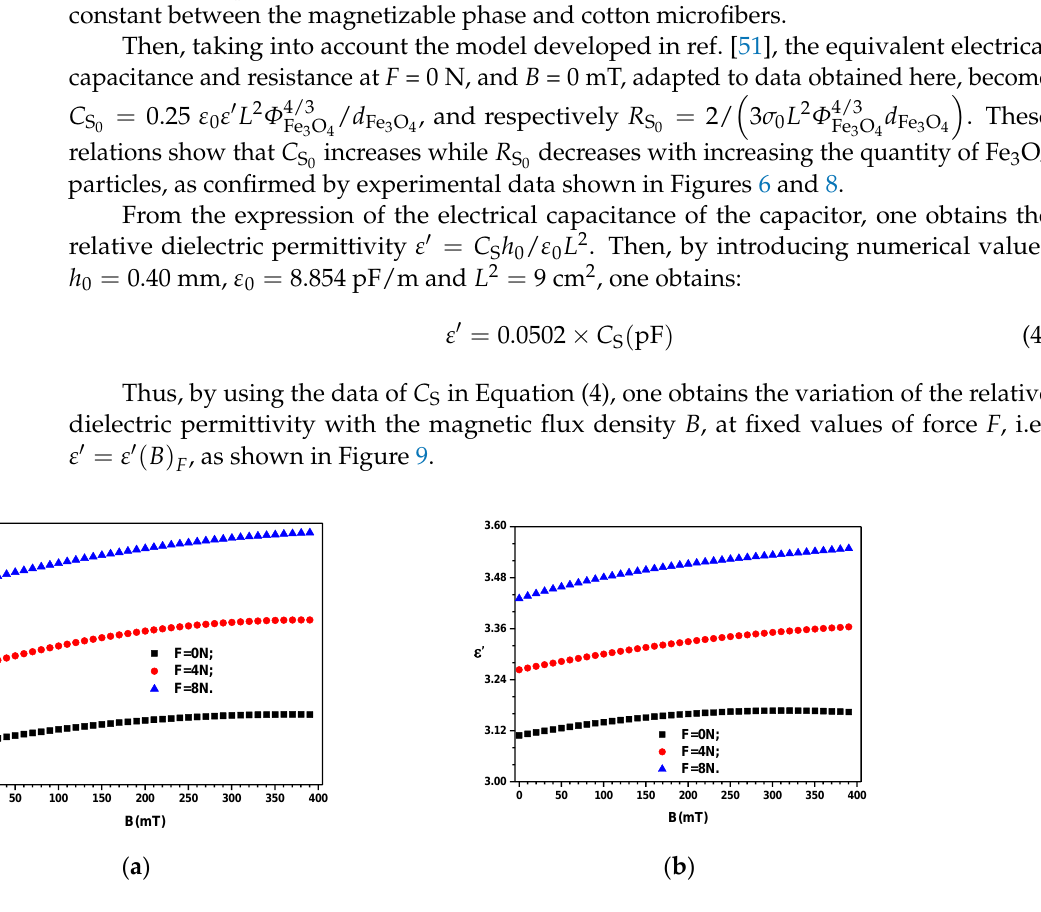
( c ) Figure 10. ( a ) Relative apparent MDE for MC 1 and MC 2 when 𝐹 ≠ 0𝑁 F. ( b ) The relative contribution 𝛢 𝜀 ′ for MC 1 . ( c ) The relative contribution 𝛢 𝜀 ′ for MC 2 . The electrical conductivity σ of the composites in the electric field of frequency f is calculated by 𝜎 = 2π𝑓𝜀 0 𝜀 ′ 𝐷 S . Thus, by using Equation (4) and 𝜀 0 = 8.854 pF/m one